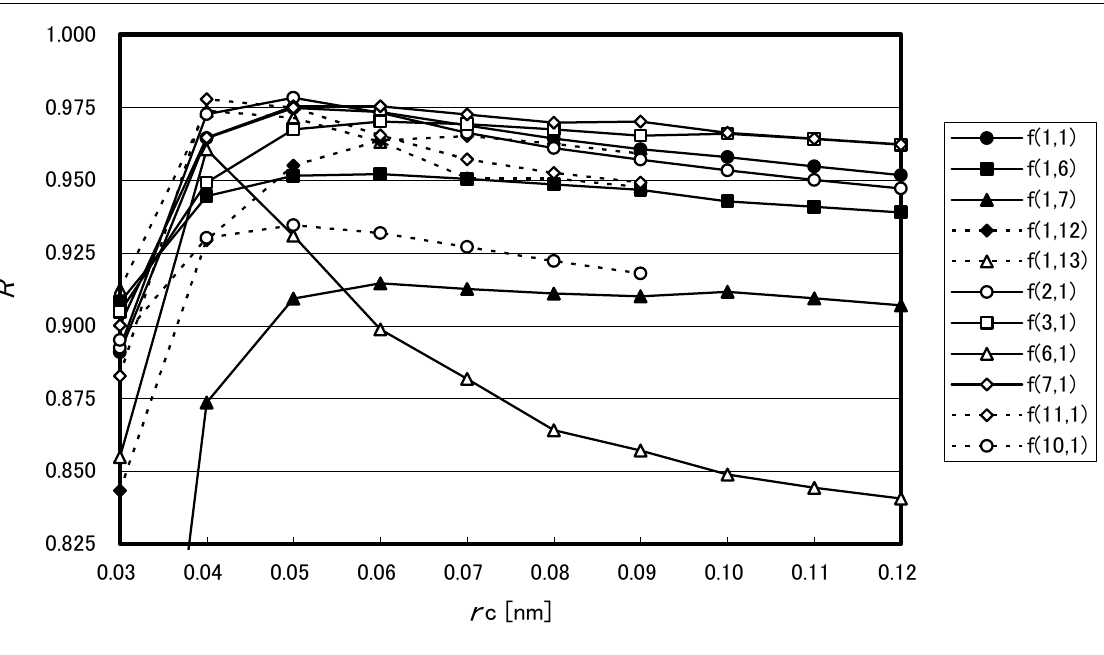
Figure 2 . The R vs. r